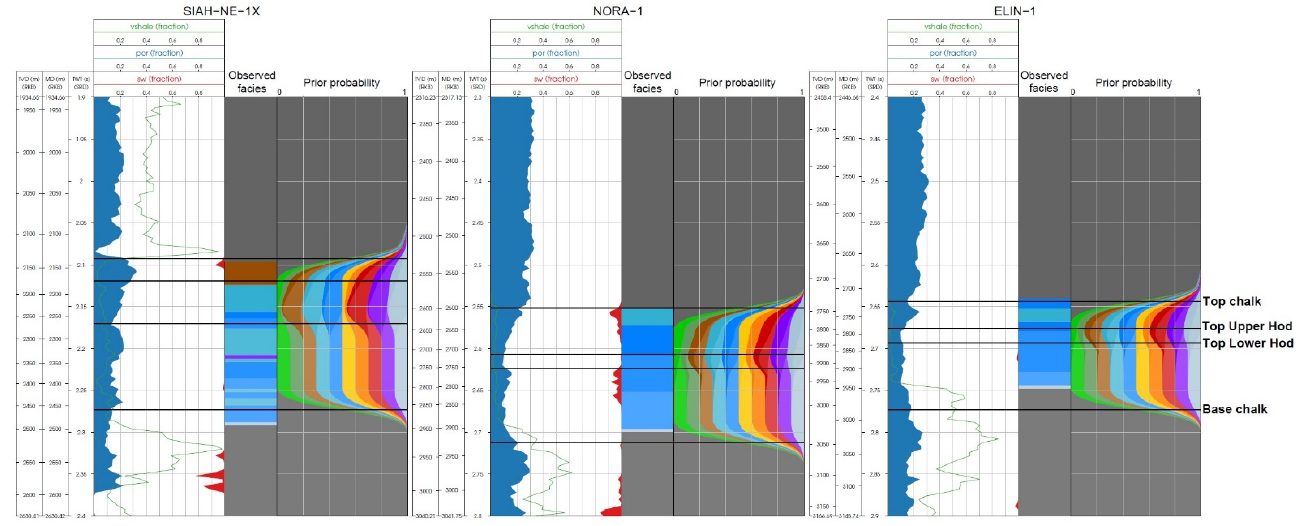
Figure 9. Prior model setup for the Siah-NE-1X ( left ), Nora-1 ( middle ) and Elin-1 ( right ) wells. For each well from left-to-right, shale volume (vclay), porosity (por) and water saturation logs; observed (or reference) facies profile; and the prior probabilities as a function of time/depth. The four seismic surfaces are plotted: Top Chalk, Top Upper Hod, Top Lower Hod and Base Chalk.